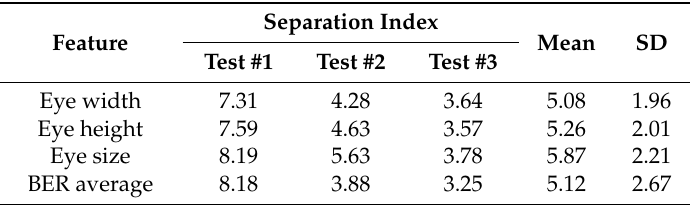
Table 2. Separation analysis results of the BER features.